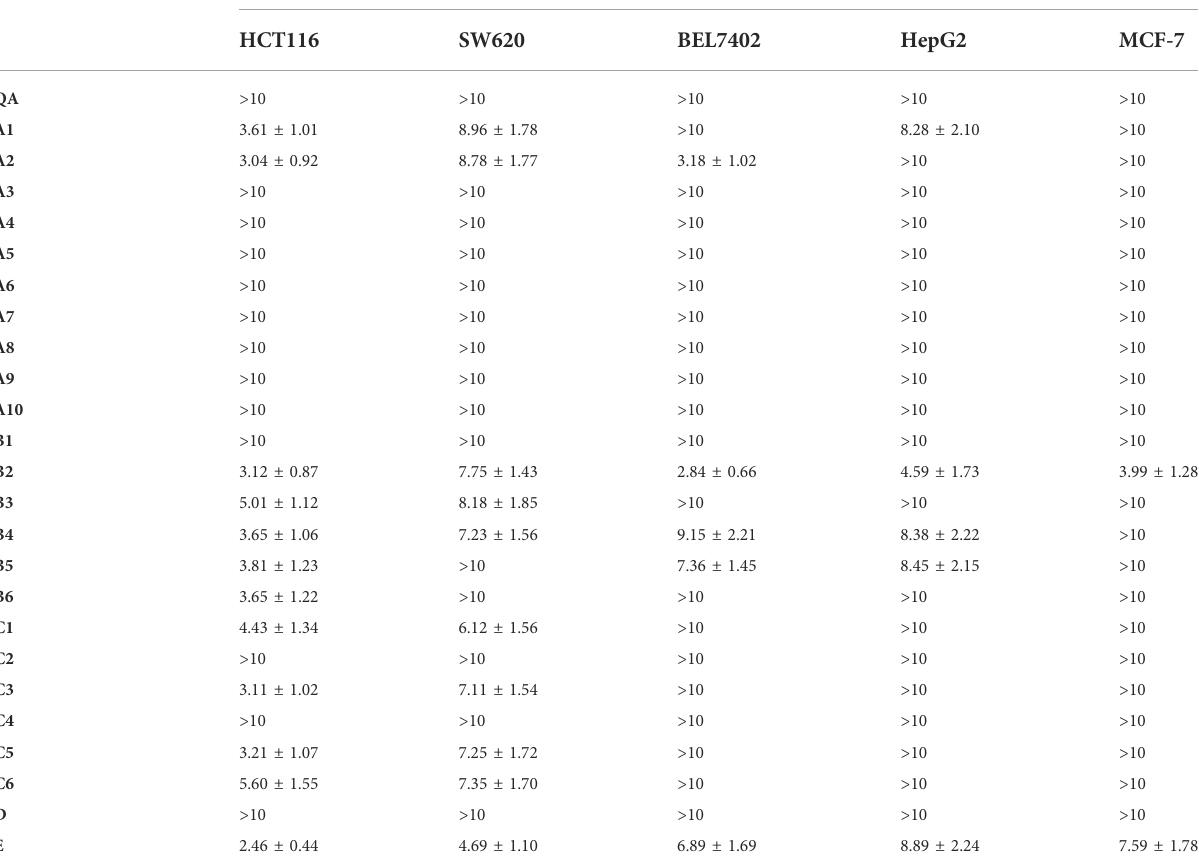
TABLE 1 Antiproliferative ef fi cacy of quillaic acid derivatives of compounds A1- A10, B1-B6, C1-C6, D, and E in three human cancer cell lines a .